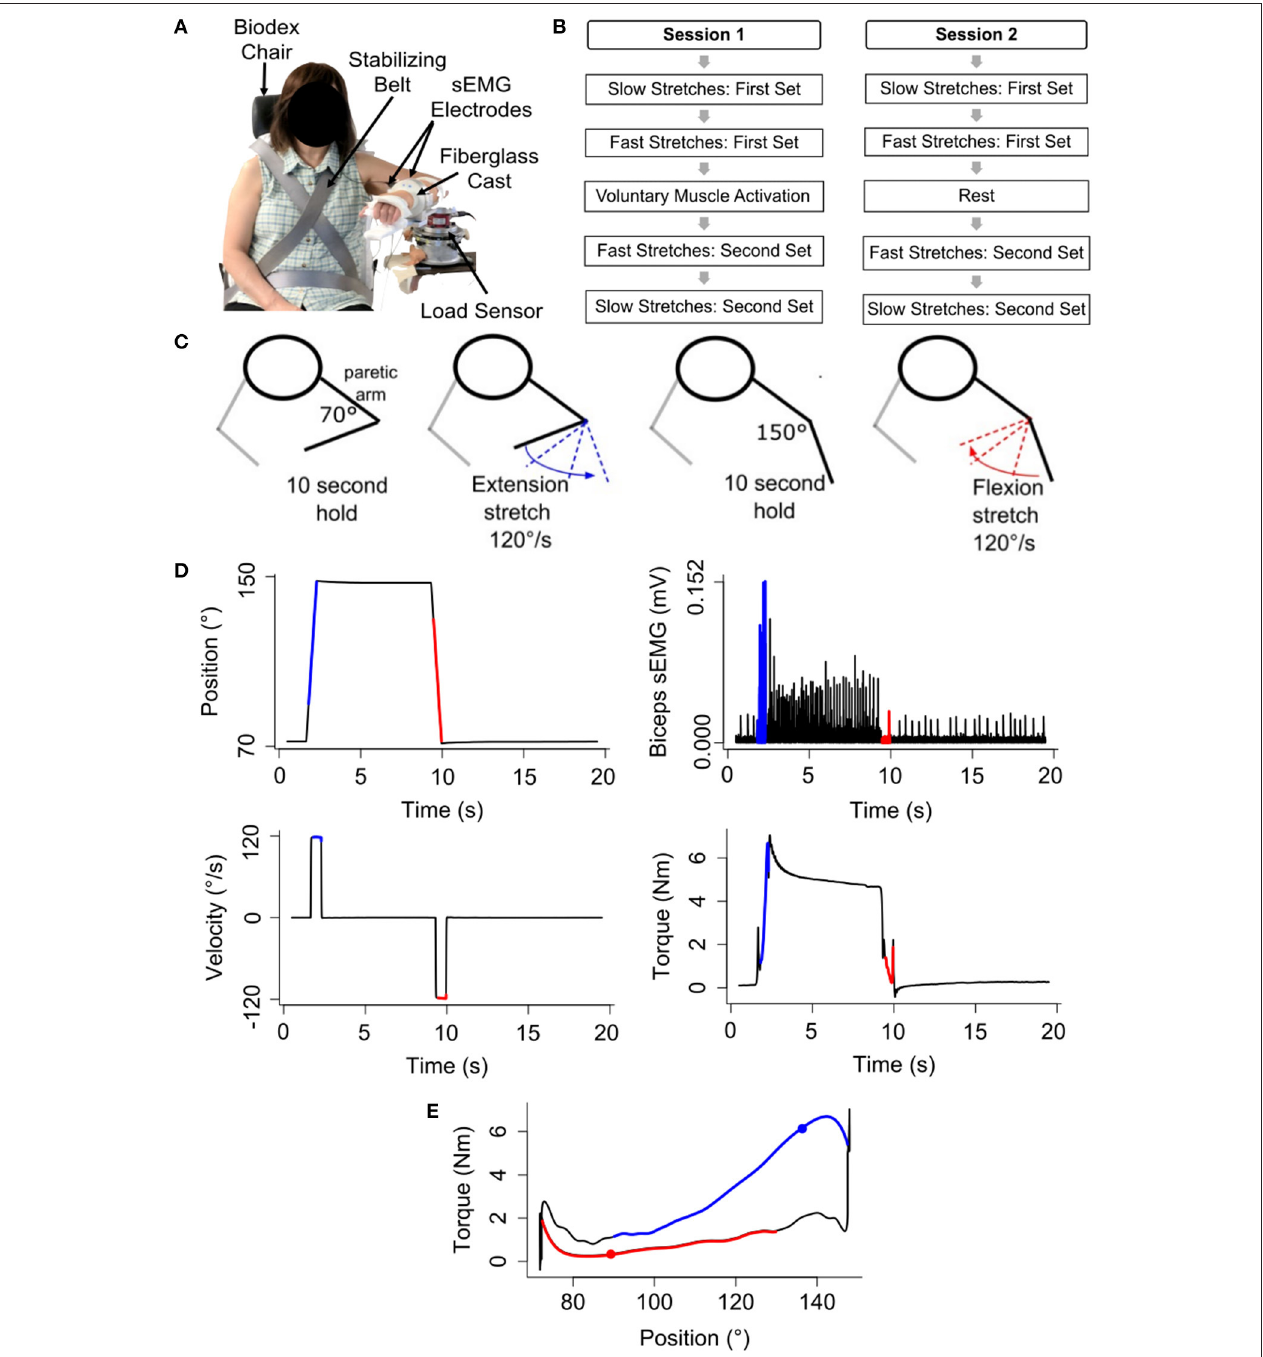
FIGURE 1 | Experimental setup and procedures. (A) Participant sitting with their paretic forearm affixed to the robotic device. (B) Five tasks of each session. (C) Representation of one repetition of the stretching sequence. (D) Example angular position, angular velocity, biceps brachii sEMG activity, and torque data during one repetition of the fast stretching sequence. Blue and red lines indicate the constant velocity portion in elbow extension and flexion, respectively. (E) Example torque vs. angular position data. The blue filled circle identifies the flexion torque at 135 ◦ , and the red filled circle identifies the extension torque at 88 ◦ . Blue and red lines indicate the constant velocity portion in elbow extension and flexion,